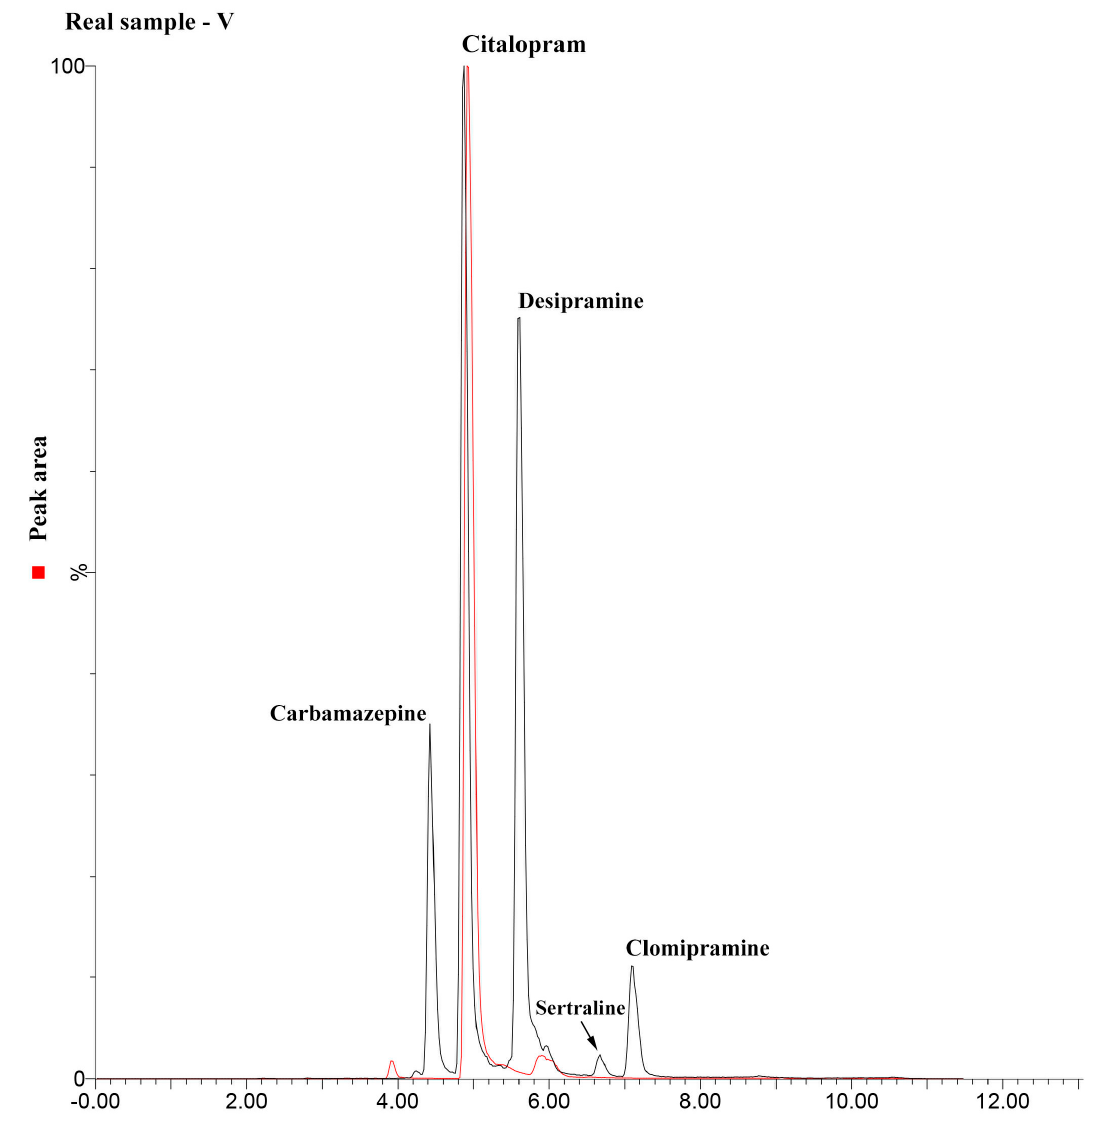
Figure 4. Chromatogram comparing a 150 µg L − 1 spiked urine with a sample from a volunteer (red line) in which traces of citalopram were found.